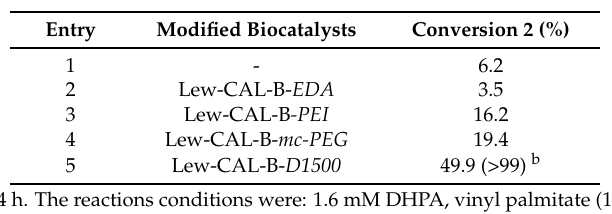
Table 2. Synthesis of monopalmitoylated DHPA catalysed by different chemically modified derivatives of the Lew-CAL-B a .